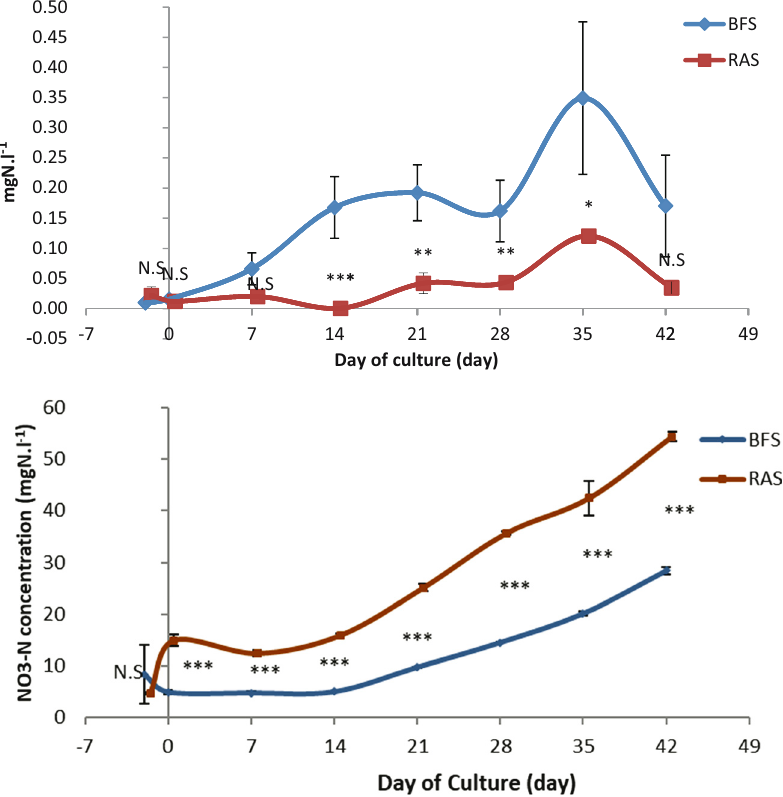
Figure 3: The concentration of total nitrite nitrogen ( NO 2 – N ) and total nitrate - nitrogen ( NO 3 – N ) in the rearing water of recirculating aquaculture system and BFS, recorded weekly. N.S means the average value is not signi fi cantly di ff erent; * represents a signi fi cant di ff erence p < 0.05; ** represents a signi fi cant di ff erence p < 0.01; *** represents a signi fi cant di ff erence p < 0.001.